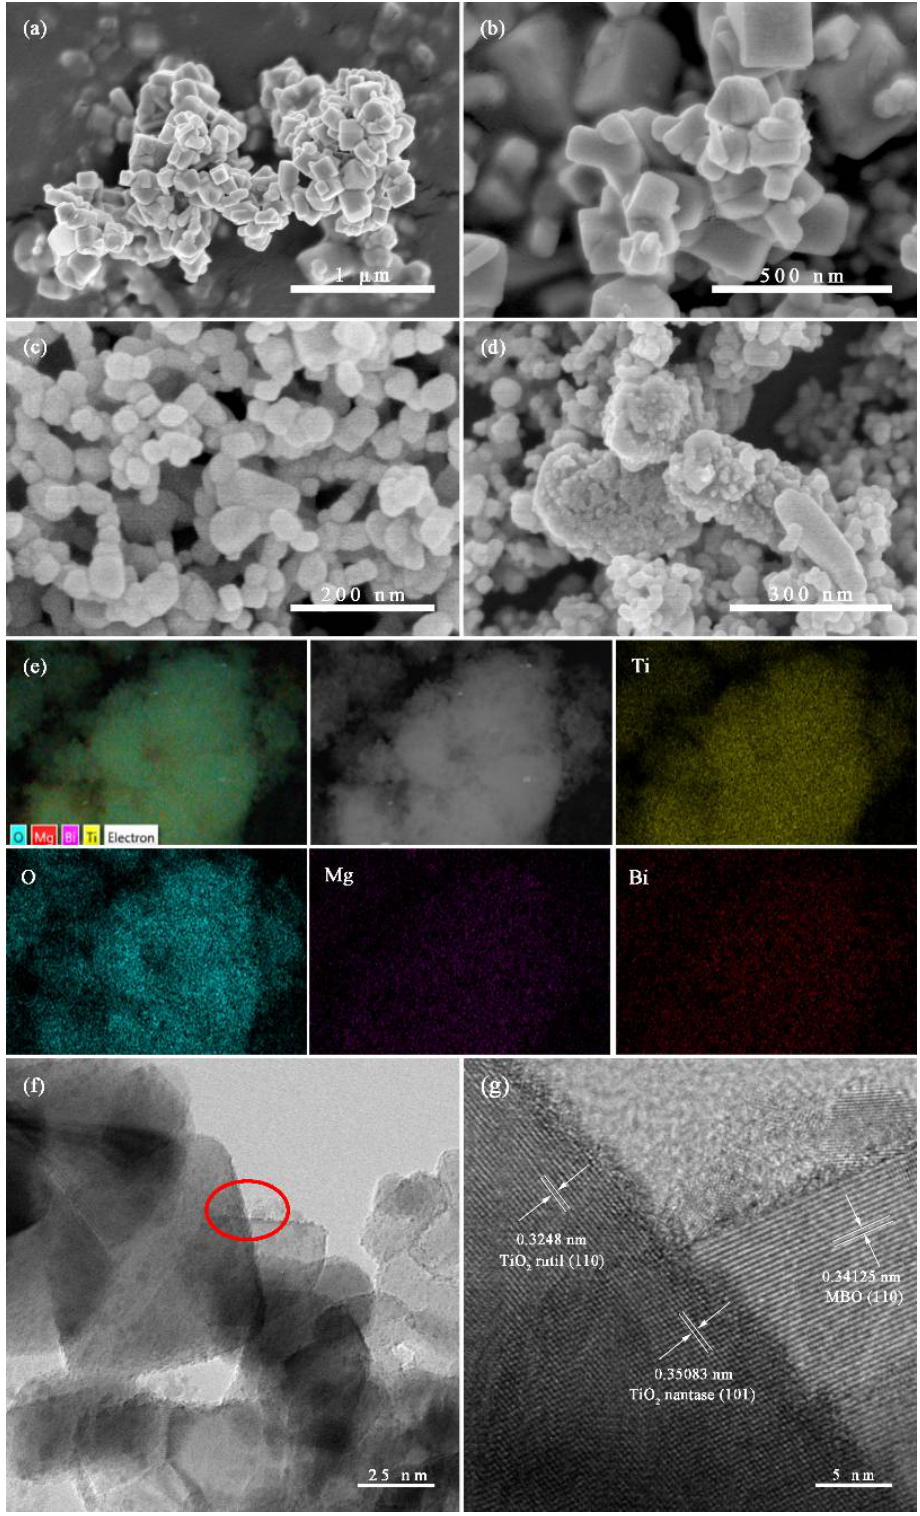
Figure 2. SEM images of ( a , b ) MBO, ( c ) TiO 2 , ( d ) 0.2 MBO/TiO 2 , ( e ) EDS elemental mapping images, ( f ) TEM and ( g ) HRTEM images of 0.2 MBO/TiO 2 .